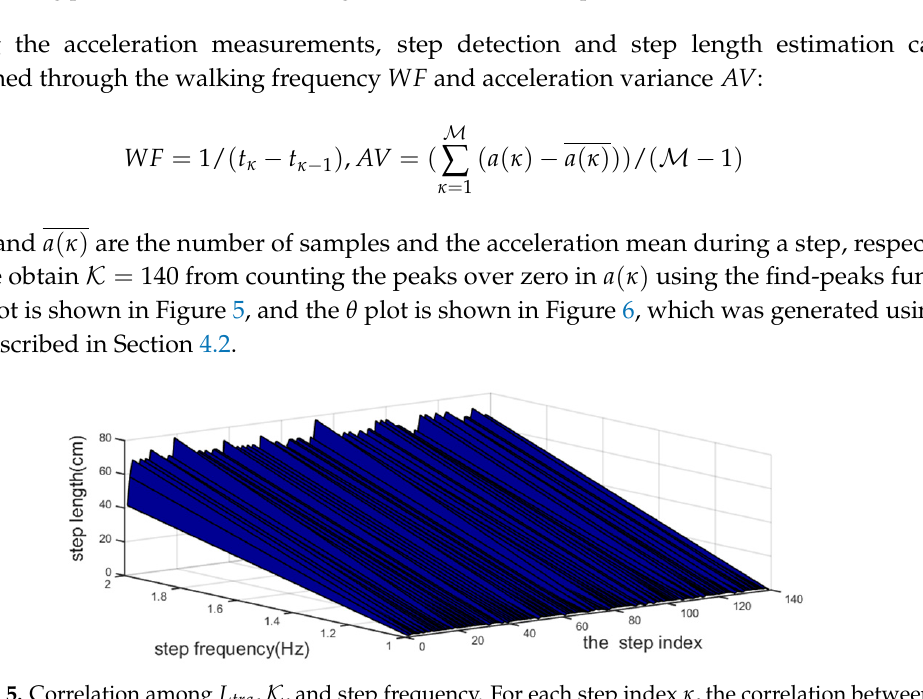
Figure 4. Illustration of 𝑎(𝜅) , which is the acceleration pattern of a pedestrian in walking states. The zero crossing points, shown in red rectangles, are the detected steps.